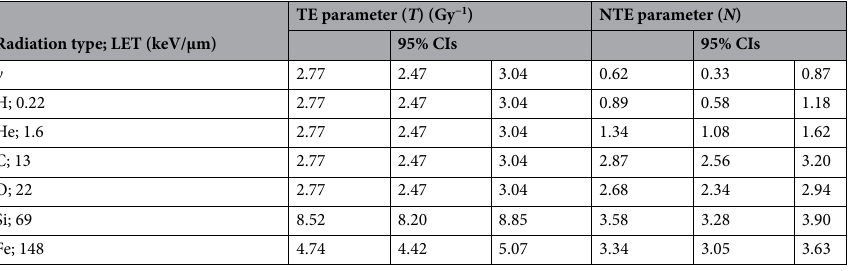
Table 1. Best-fit parameters for TE and NTE from the dose–response model (Eq. A2) fitted to mouse tumorigenesis data. Details of the method are described in the main text and in Appendix 1 (see Supplementary Data online). Notably, the T and N parameters have different units. N represents the “plateau” to which NTE saturate at high doses, and is therefore unitless. In contrast, T is a linear dose response slope for TE, with units of Gy −1